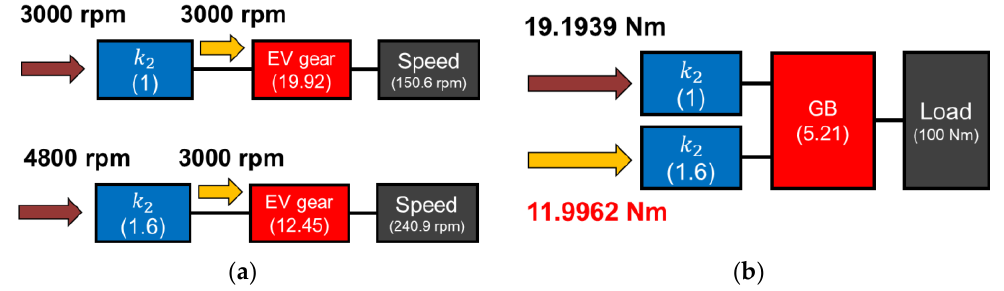
Figure 14. ( a ) Influence of di ff erent k 2 and electric vehicle (EV) gear ratio and ( b ) influence of torque